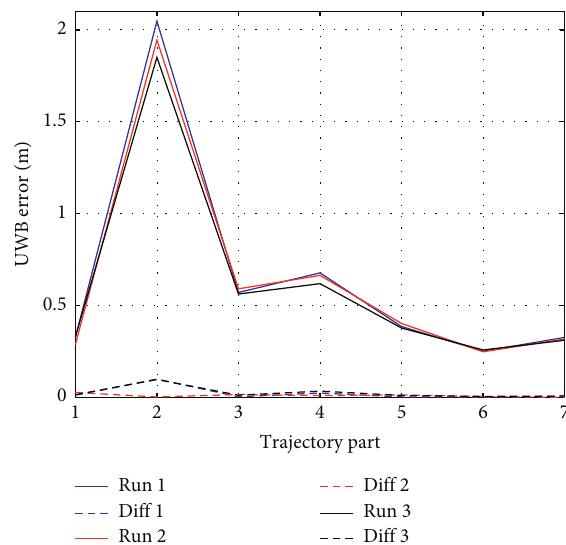
Figure 19: The difference between the UWB and RTK-SN posi- tions for the three reruns of the experiment shown in Figure 18. The dotted lines show the difference from each individual test to the